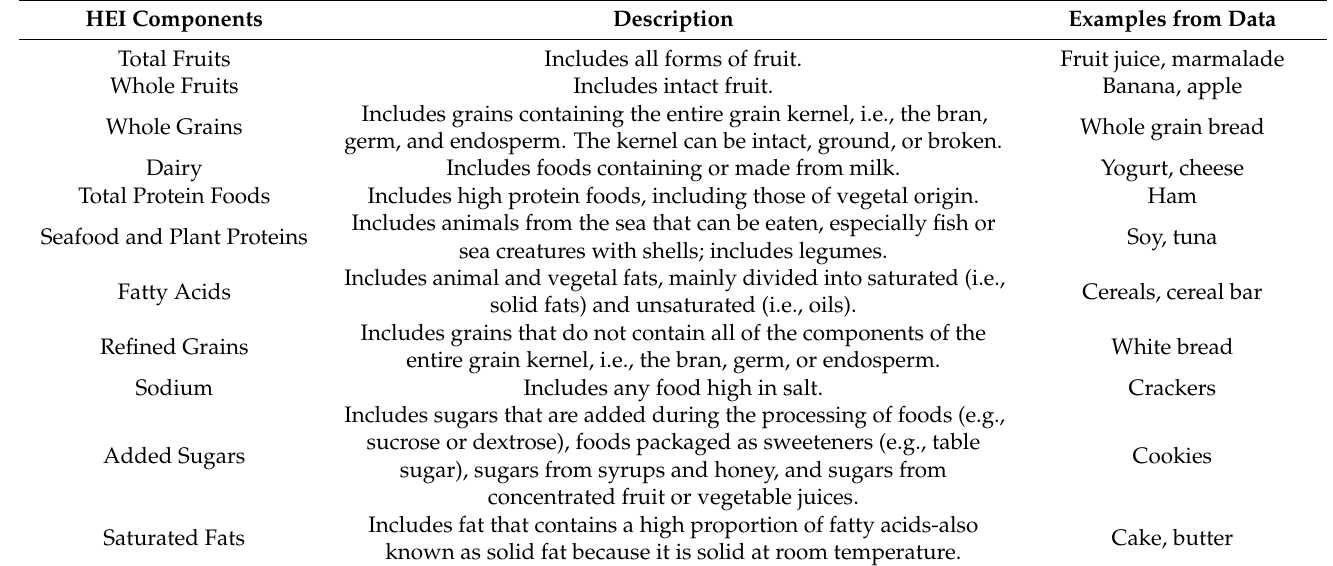
Table 1. Codebook with the HEI components present in the data and correspondent